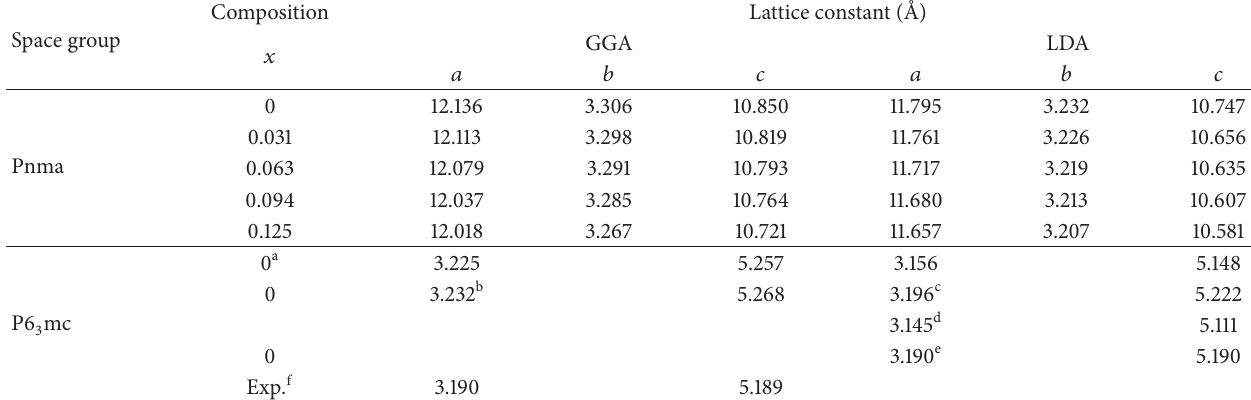
Composition Lattice constant (˚A) Space group 𝑥 GGA LDA 𝑎 𝑏